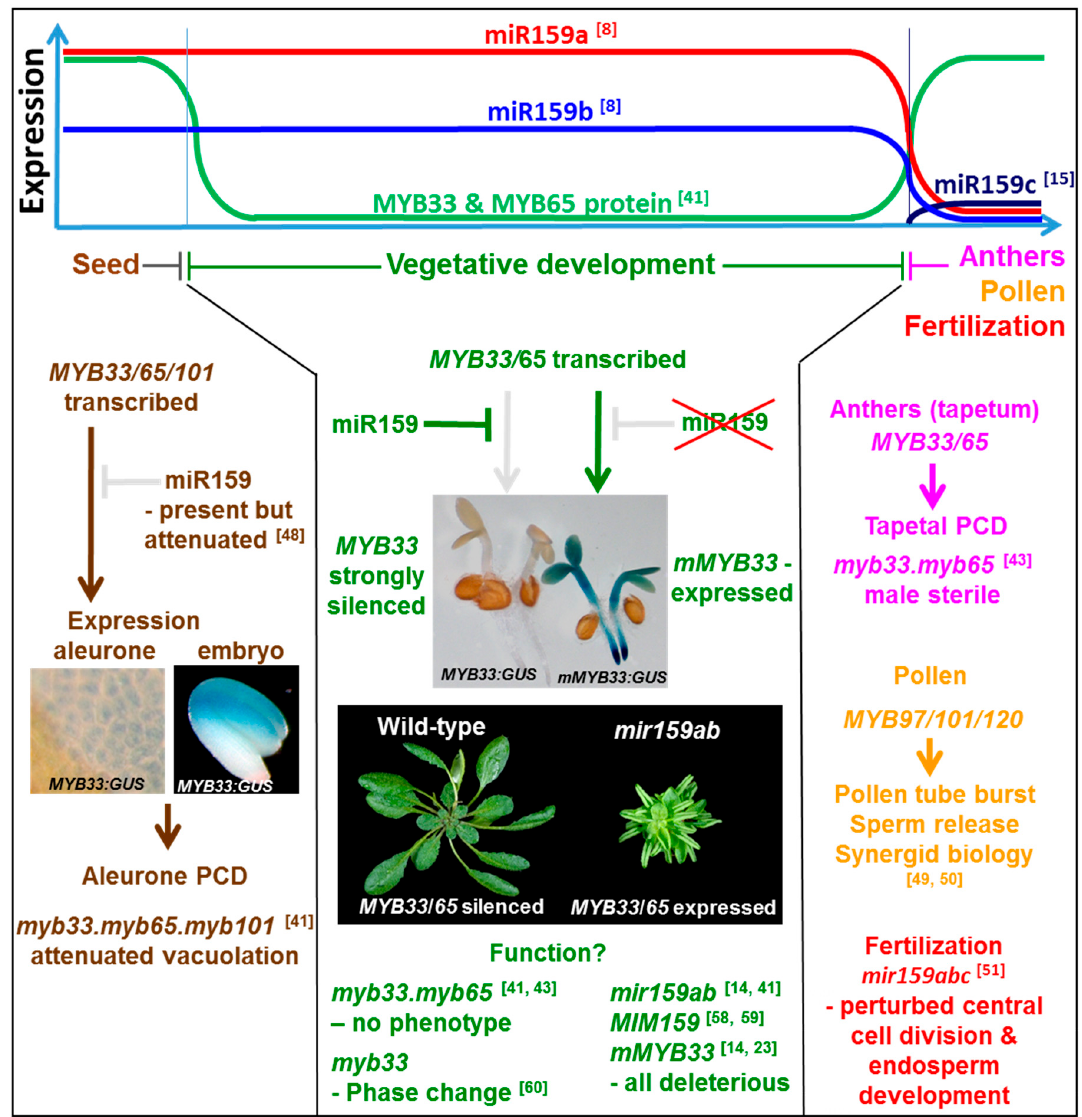
Figure 2. The miR159-GAMYB-like pathway in Arabidopsis. miR159a is the predominant family member, being expressed in seed and throughout plant development at a constantly high level, but it is absent in anthers [8,14,46]. miR159b is expressed at a lower level than miR159a [8,15,46], but its expression pattern appears highly similar to miR159a [14]. miR159c, is weakly expressed and appears mainly confined to anthers [15]. In seeds, miR159 efficacy appears attenuated [48], enabling GAMYB- like gene expression which promotes PCD of the aleurone [41]. In contrast, throughout vegetative development, miR159 efficacy is strong, and MYB33 / 65 expression is strongly silenced. Only via inhibition of miR159, or mutation of the miR159 binding site within MYB33 or MYB65 , will expression occur, which leads to strong deleterious outcomes, such as stunted growth and curled leaves [14,41]. Although the function of the pathway has been suggested to be involved in flowering-time and phase change, the purpose of this pathway in vegetative development is still unclear. In anthers, miR159 activity is low. Here, MYB33 and MYB65 are expressed to promote PCD in the tapetum [43]. MYB97 / 101 / 120 expression is required for pollen function [49,50]. Finally, miR159 is required for fertilization [51].